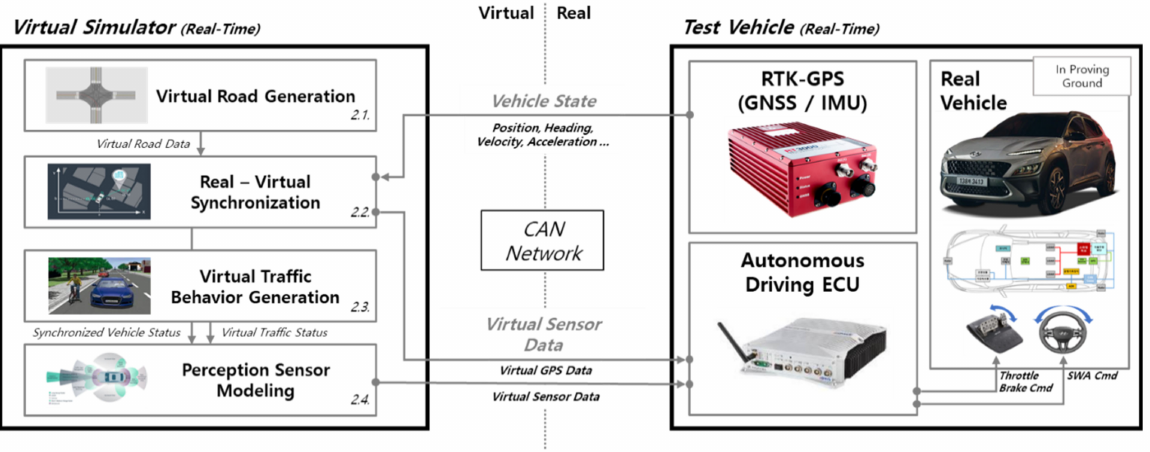
Figure 2. Proposed PG-based VILS System